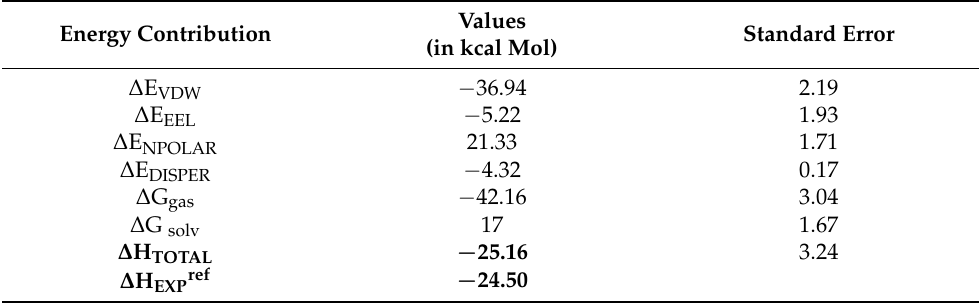
Table 1. Energy contribution when GP120 binds with NBD in the absence of antibody. Here, ∆ E VDW = change in van der Waals interaction on ligand associations, static interaction on ligand associations, ∆ E polar = change in polar interaction on ligand associa- tions, ∆ E nonpolar = change in nonpolar interaction on ligand associations. ∆ G gas = ∆ E VDW + ∆ E EEL